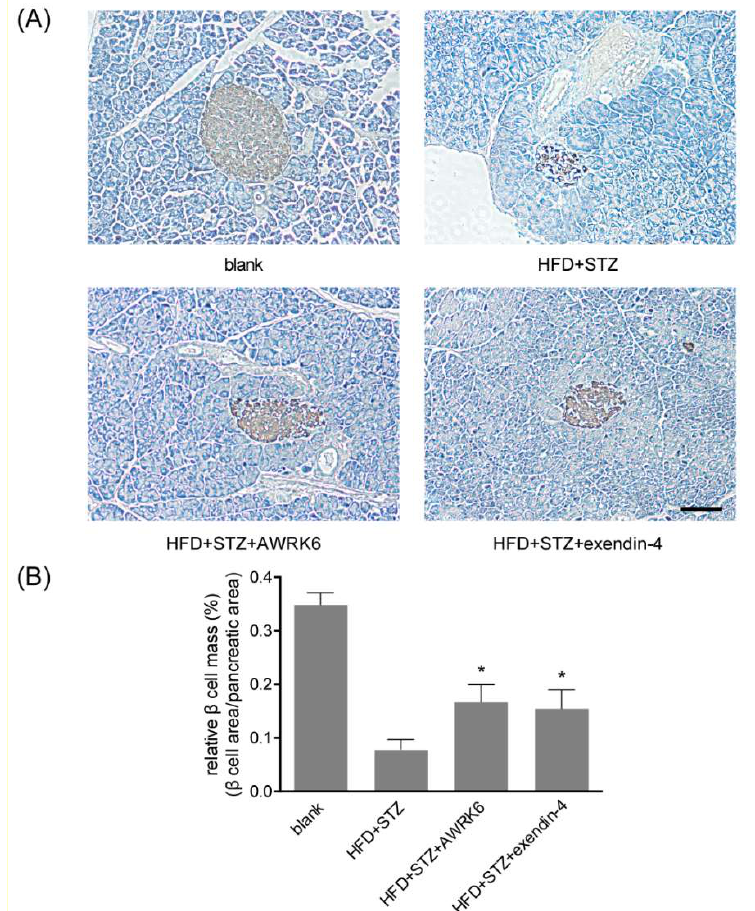
Figure 2. AWRK6 treatment increased the relative β cell mass in diabetic mice. ( A ) The representative immunohistochemistry (IHC) images of the pancreas, stained with an anti-insulin antibody. Bar indicates 100 μm. ( B ) The relative β cell mass was analyzed using ImageJ software. The error bar indicates standard deviation. * p < 0.05 compared with the diabetes groups.